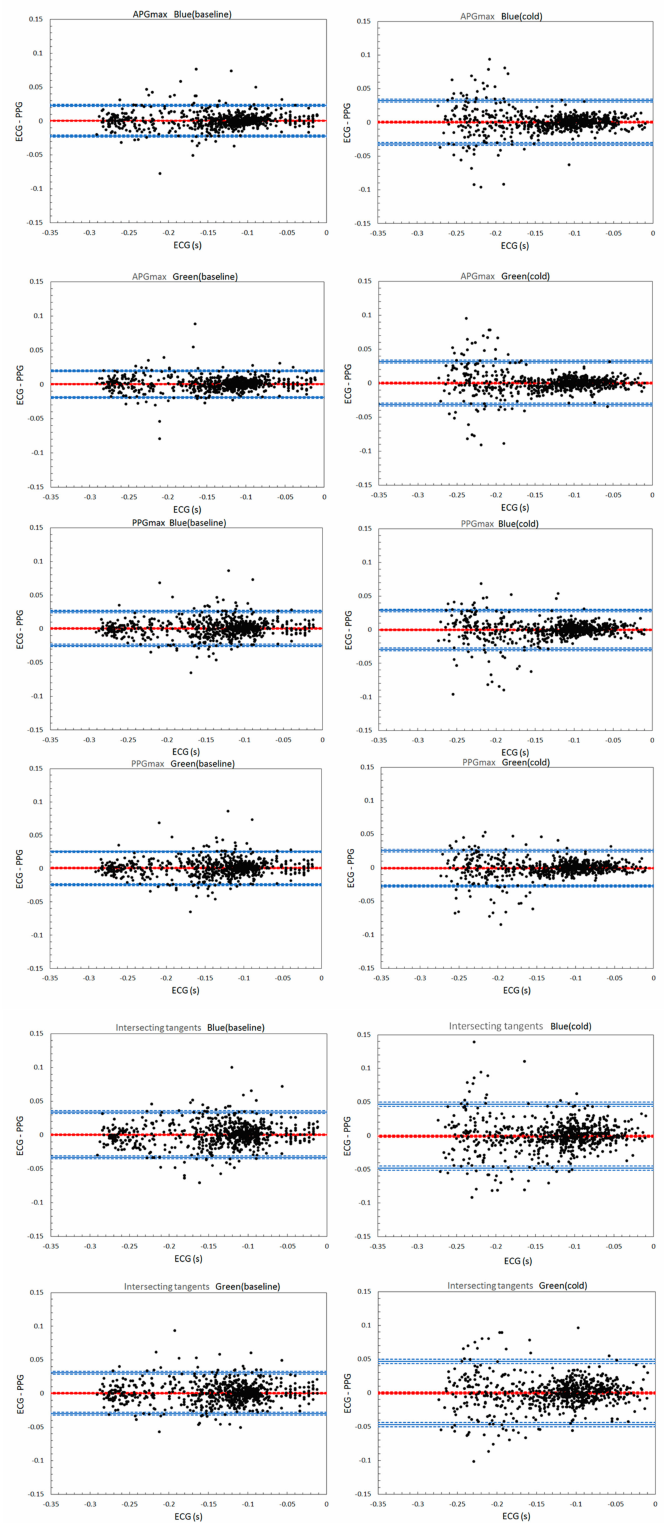
Figure A1. Bland-Altman plots for 720 ECG-PPG data pairs. The bias and LOA are displayed as red and blue solid lines, respectively. Their CI are displayed as dotted